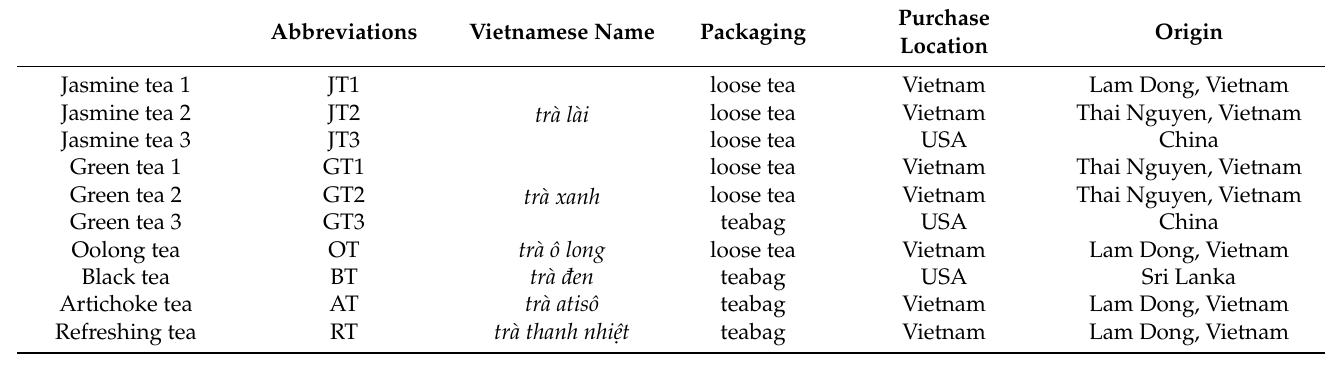
Table 1. Summary of the teas examined in this study.